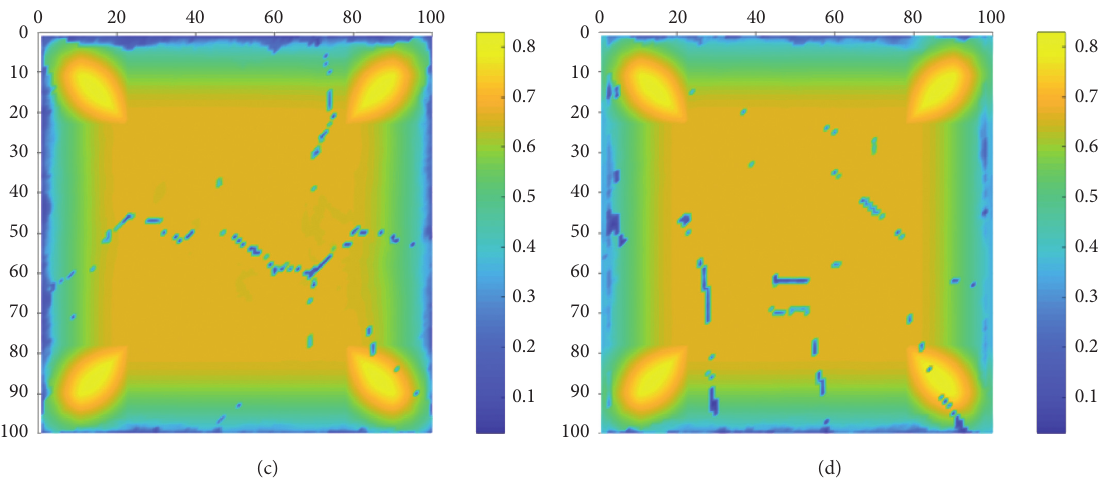
Figure 19: Percolation result of 100 resolution images using the existing percolation method: (a) image 1; (b) image 2; (c) image 3; (d) image 4.